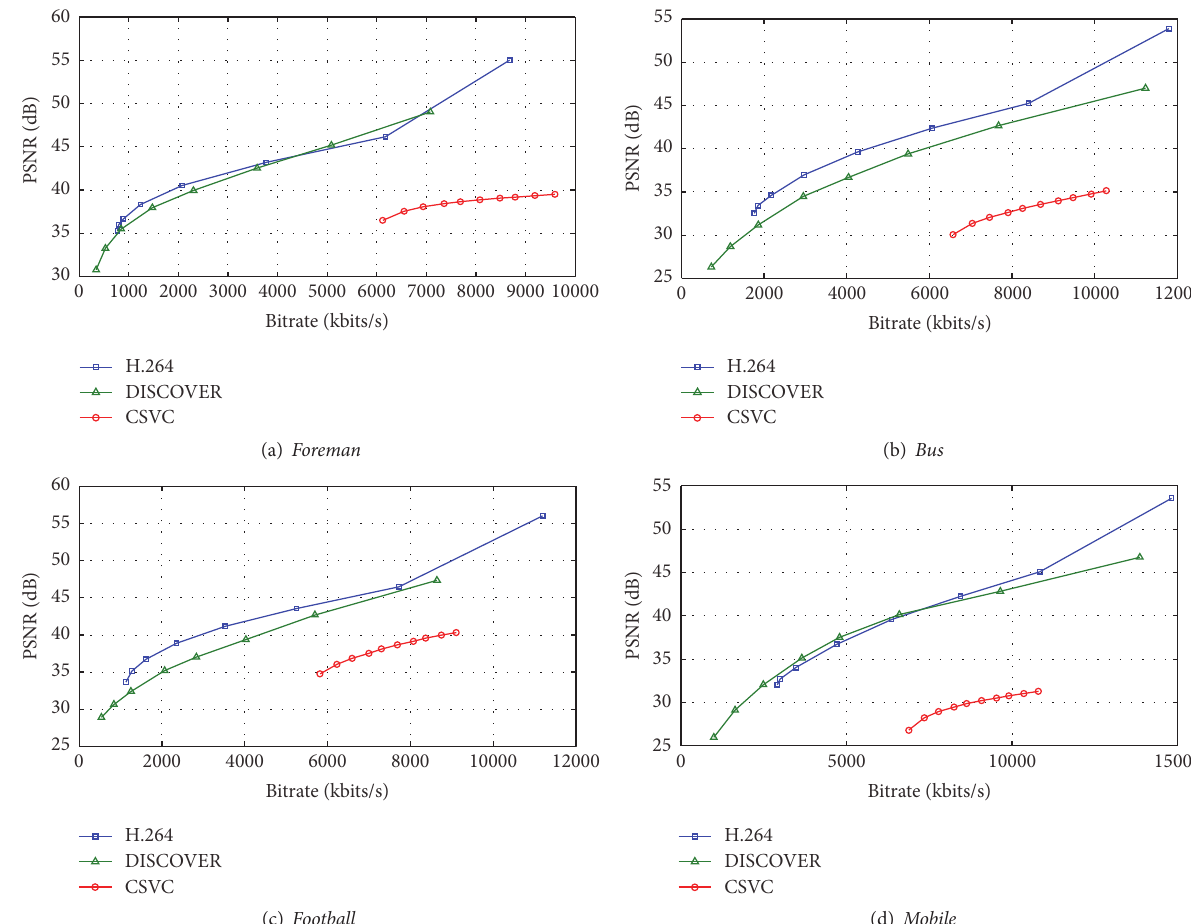
Figure 5: Comparison of rate-distortion performance of H.264, DISCOVER, and CSVC encoder under different test video sequences.